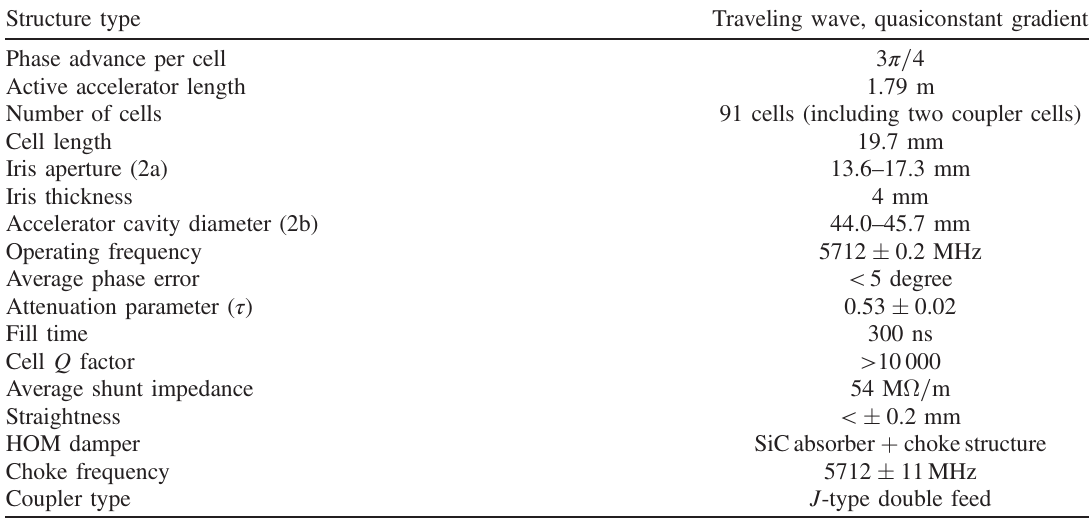
TABLE I. C -band structure